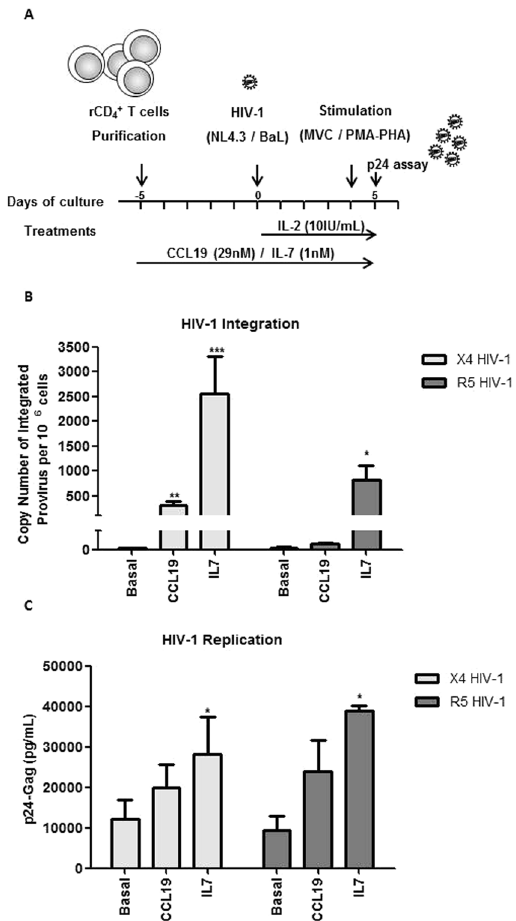
Figure 1. Proviral Integration in HIV-Infected rCD4 + lymphocytes treated with CCL19 or IL-7. CD4 + lymphocytes were treated with CCL19 or IL-7 for 5 days and then infected with X4-tropic NL4–3 strain or with R5-tropic BaL strain and cultured for 5 additional days. ( A ) Scheme of HIV-1 primary cells latency models. ( B ) qPCR analysis of HIV-1 proviral integration. ( C ) HIV-1 basal replication was assessed by quantifying p24/Gag levels in the culture supernatant. Statistical significance was calculated by using Kruskal-Wallis test with Dunn’s Multiple Comparison Test ( * p < 0.05, ** p < 0.01 and *** p < 0.001). Data are represented as mean ±